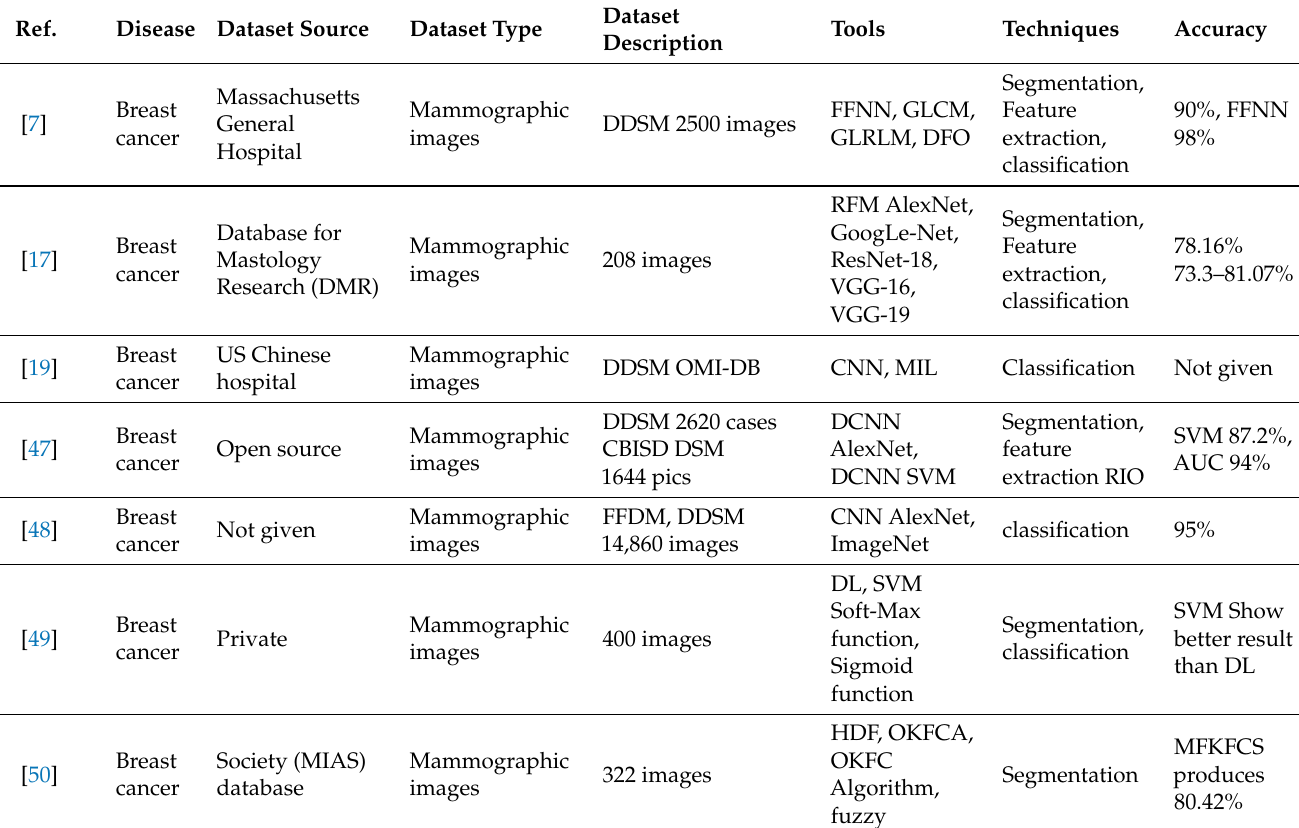
Table 3. Existing techniques on mammographic images